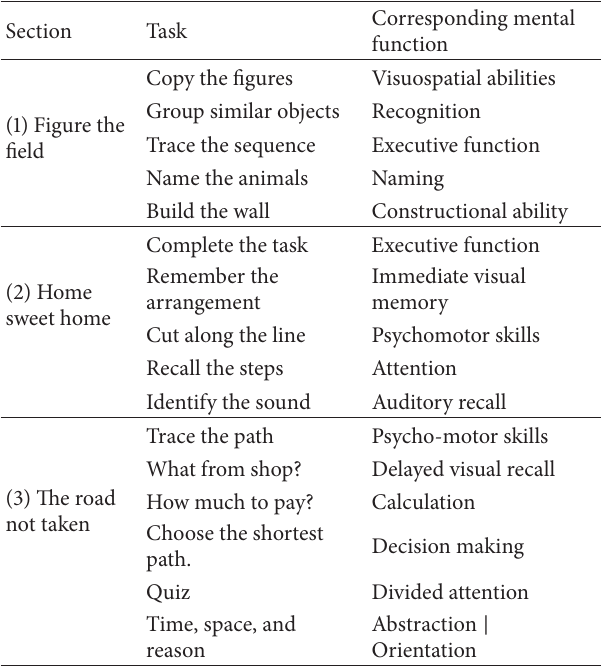
Table 1: MALT-steps